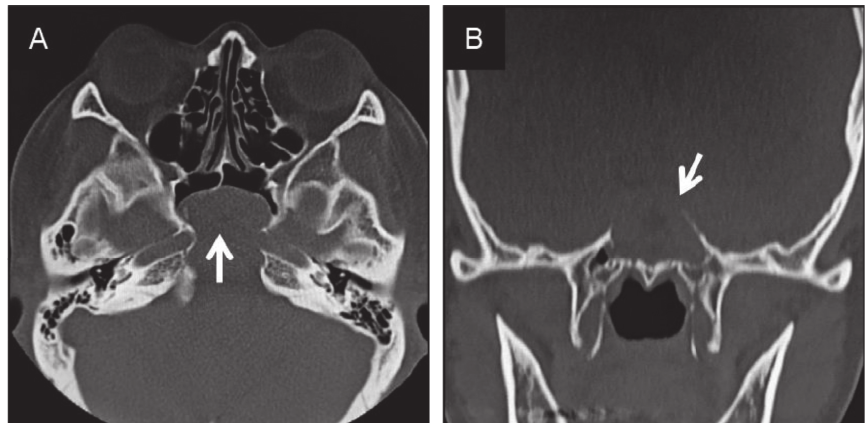
Figure 1: Noncontrast computed tomography imaging of the paranasal cavity at the initial diagnosis. (a) Axial and (b) coronal views. We confirmed the presence of soft tissue contrast, suggesting a retention cyst at the rear sphenoid sinus, with thinning at the sella turcica and left internal carotid artery and elimination of the clivus (white arrows).